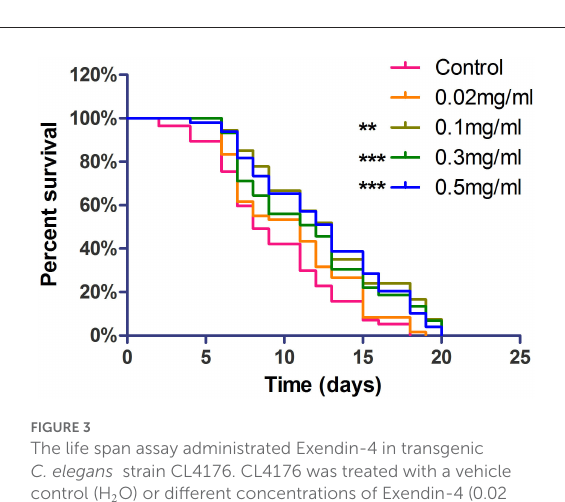
FIGURE3 The life span assay administrated Exendin-4 in transgenic C. elegans strain CL4176. CL4176 was treated with a vehicle control (H 2 O) or different concentrations of Exendin-4 (0.02 mg/ml, 0.1 mg/ml, 0.3 mg/ml, and 0.5 mg/ml). The median survival of worms treated with 0.5 mg/ml Exendin-4 was 13 days, which had a significant expansion compared with 8 days of control worms ( p < 0.001). The experiment was repeated independently for three